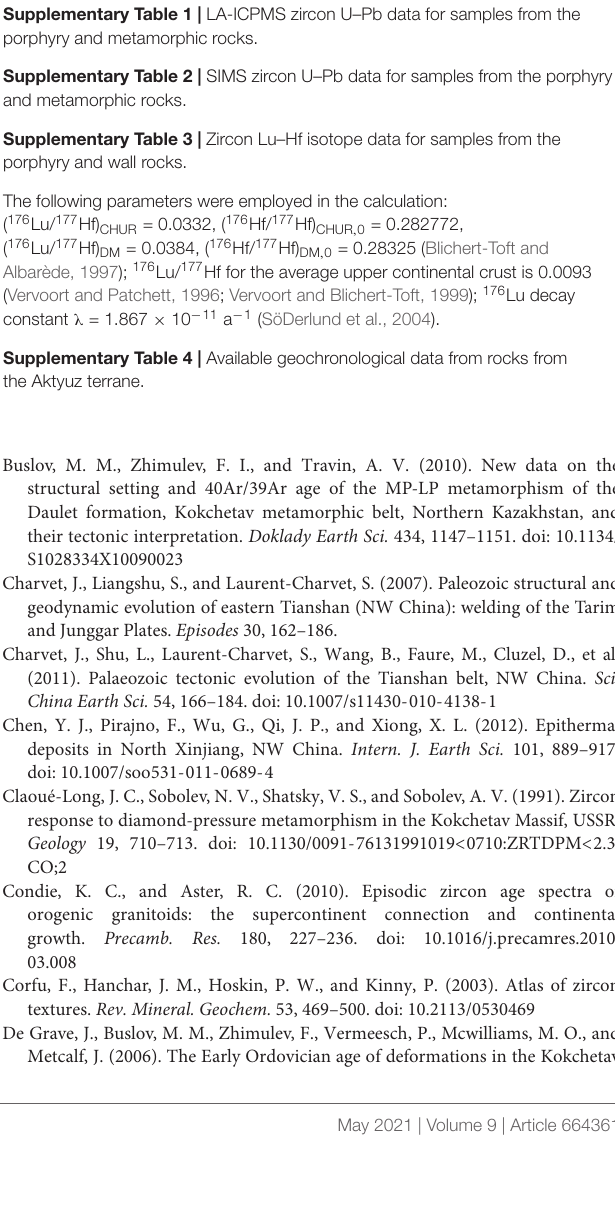
The following parameters were employed in the calculation: ( 176 Lu/ 177 Hf) CHUR = 0.0332, ( 176 Hf/ 177 Hf) CHUR , 0 = 0.282772,